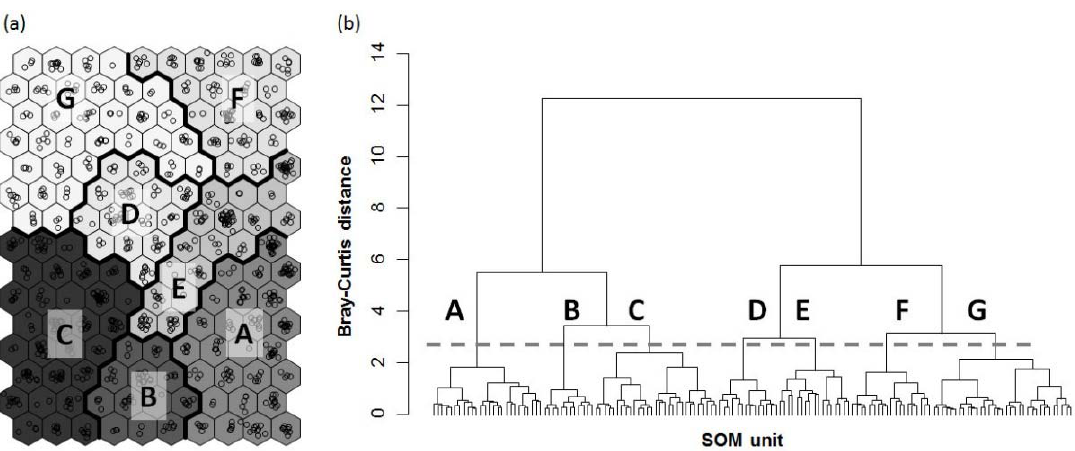
Figure 3. ( a ) Classification of sampling sites using a Self-organizing map (SOM); and ( b ) classification of SOM units based on the dendrogram of hierarchical cluster analysis with Ward linkage methods using Bray–Curtis distances. Weight vectors of SOM units were used in the hierarchical cluster analysis.